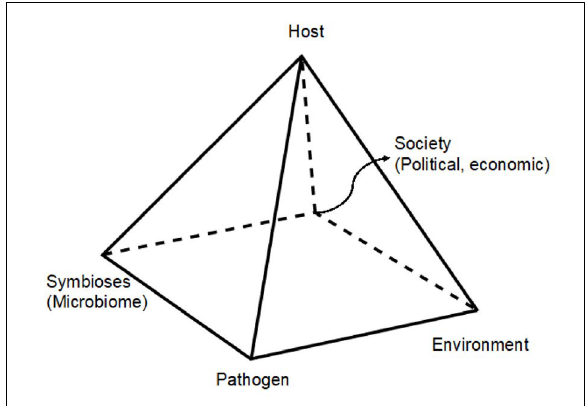
Figure 1: The Plant Disease Pyramid. Factors that influence disease development have been described in the classical ‘Disease Triangle’ concept. Recent work suggests that a fourth dimension, that of symbioses such as the microbiome are also critical to consider. 5 Here I argue for a fifth dimension, namely the societal factors (cultural, political and economic) that have profound impact on disease development and outcomes on scales from the local to the global. Social-ecological interdependencies are increasingly well defined for sustainable development 7 and would provide a useful starting point to integrate these concepts into disease development models and management